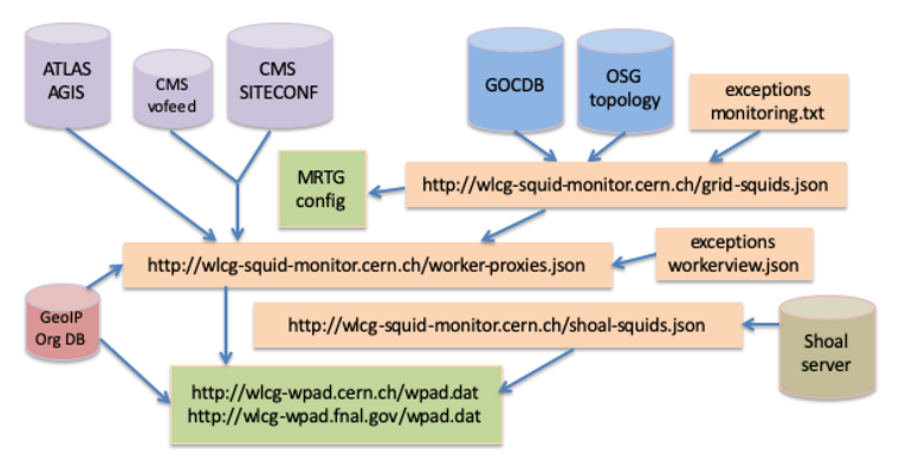
Figure 1. WLCG WPAD information